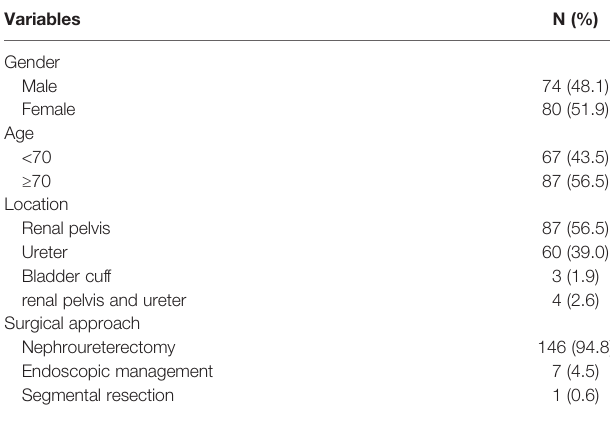
TABLE 1 | Clinical features of upper tract urothelial cancer patients for pathology